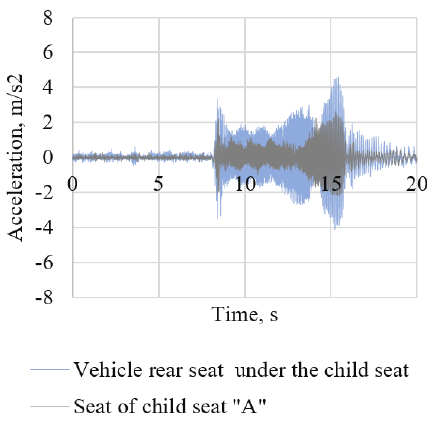
Figure 7: Vertical accelerations recorded on the seat B and ISOfix base (suspension in a raised position, the seat is loaded with a mass of 15 kg)